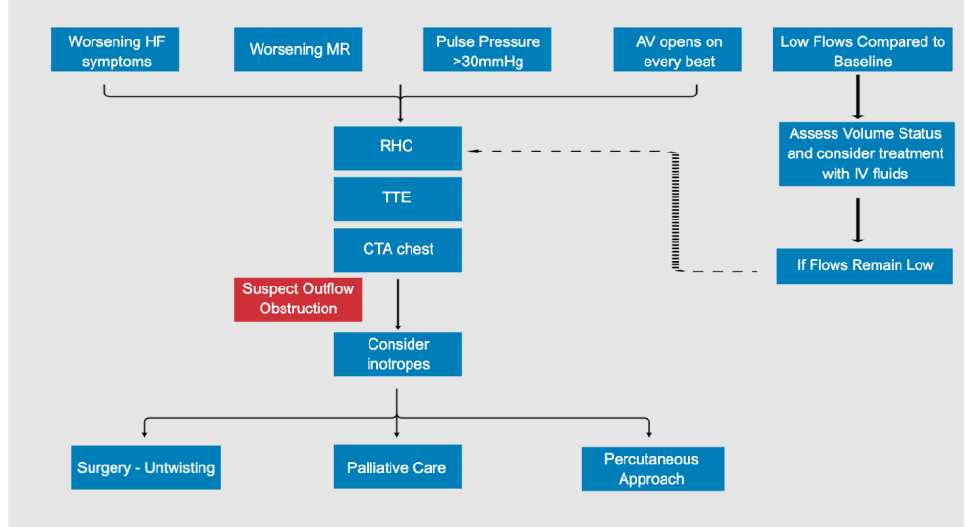
Figure 2. Algorithm for the evaluation of LVAD outflow graft obstruction. AV, aortic valve; CTA, computed tomography with angiography; HF, heart failure; IV, intravenous; MR, mitral regurgitation; RHC, right heart catheterization; TTE, transthoracic echocardiogram .